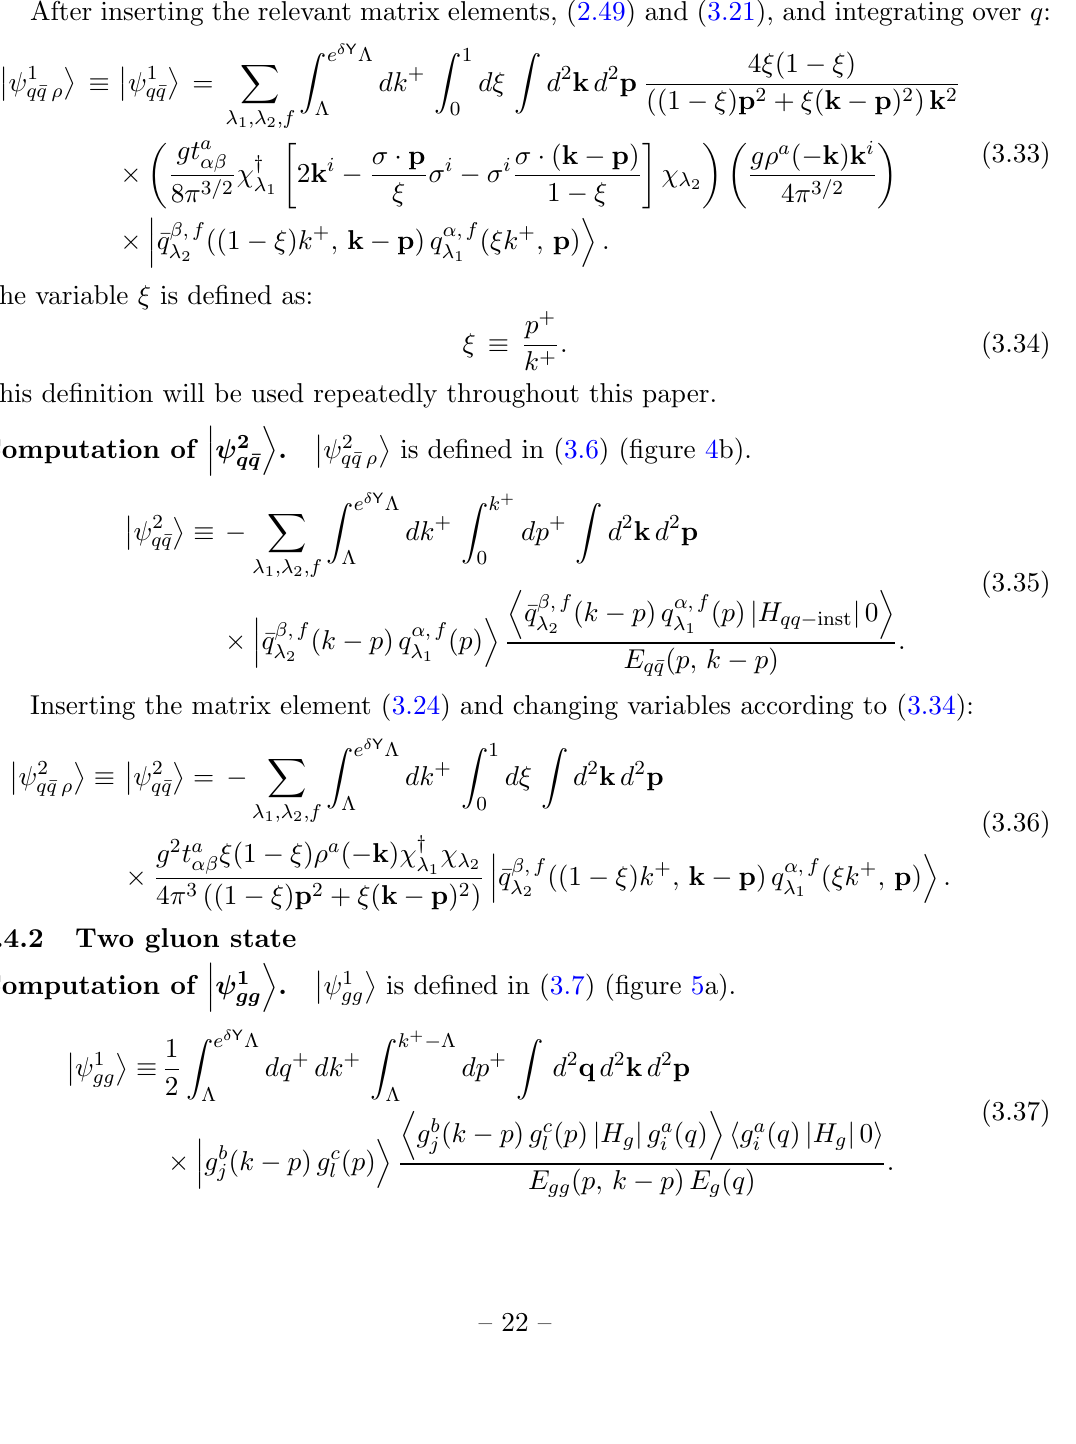
(cid:12) (cid:12) (cid:11) (cid:11) , ( b ) - . (cid:12) 1 q (cid:22) q (cid:12) 2 q (cid:22) q